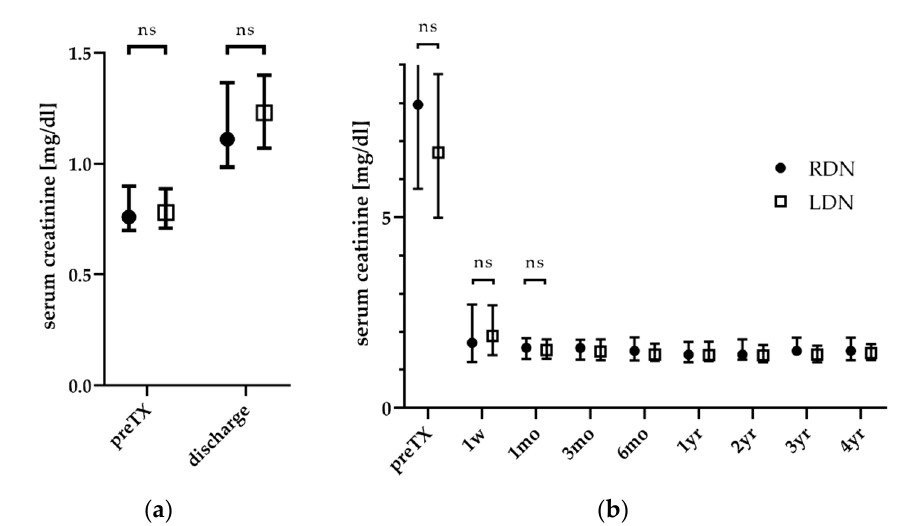
Figure 1. Follow-up of kidney function of the donor ( a ) and graft ( b ). The kidney function did not differ between robot-assisted (RDN) and laparoscopic donor nephrectomy (LDN).